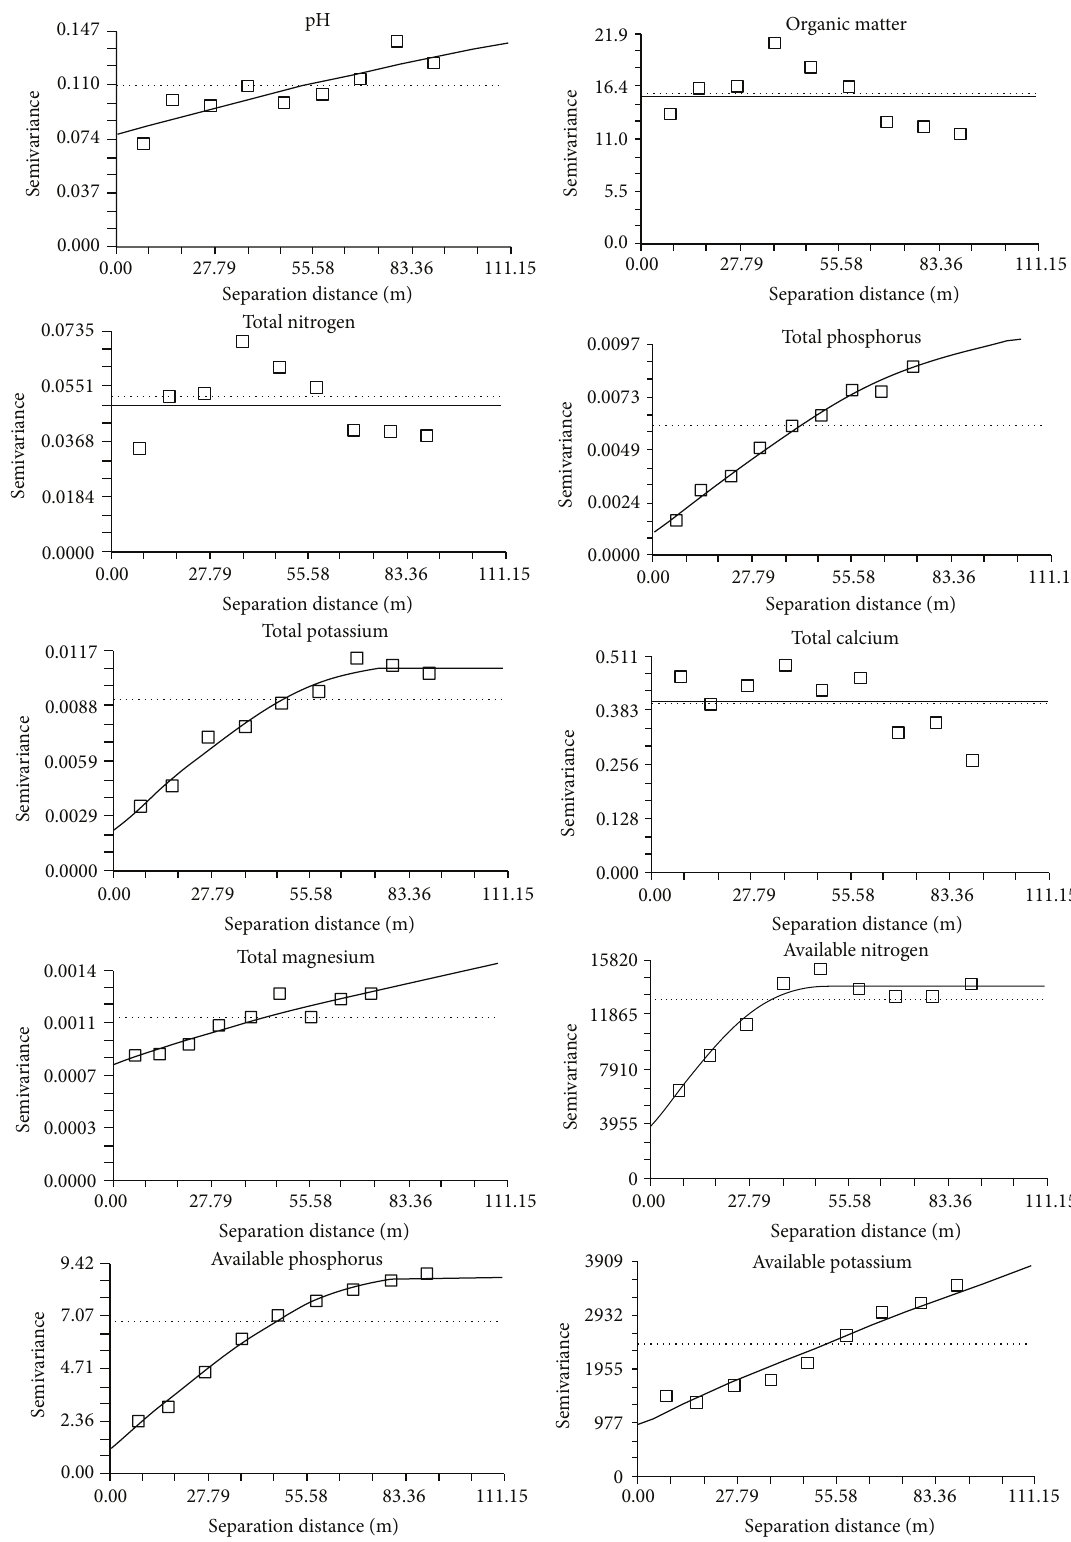
Figure 2: Semivariograms of the soil chemical properties on the top forest soil (0cm to